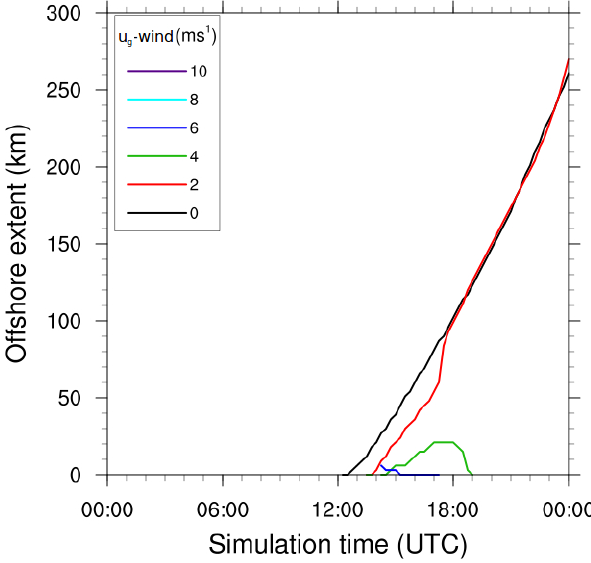
Fig. 10. Sensitivity of onset time and offshore extent of a single coast pure sea breeze to the strength of the offshore gradient flow ( U g ). In all tests, the YSU PBL scheme was used along with a SST of